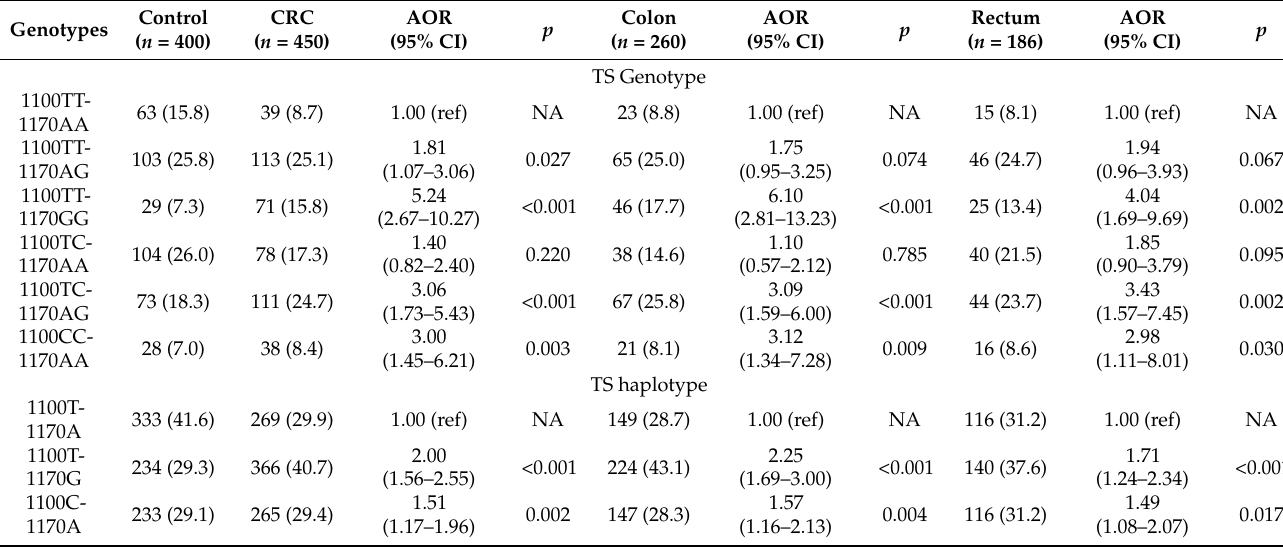
Table 3. Combined genotype and haplotype frequencies of TS 3 (cid:48) -UTR polymorphisms between CRC patients and control